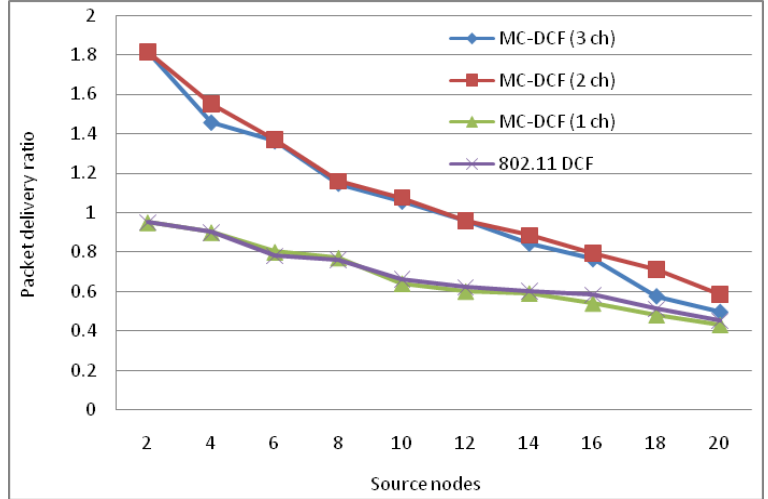
Figure 17. Delivery ratio impact from sources when using multiple sinks with multiple radio interfaces.